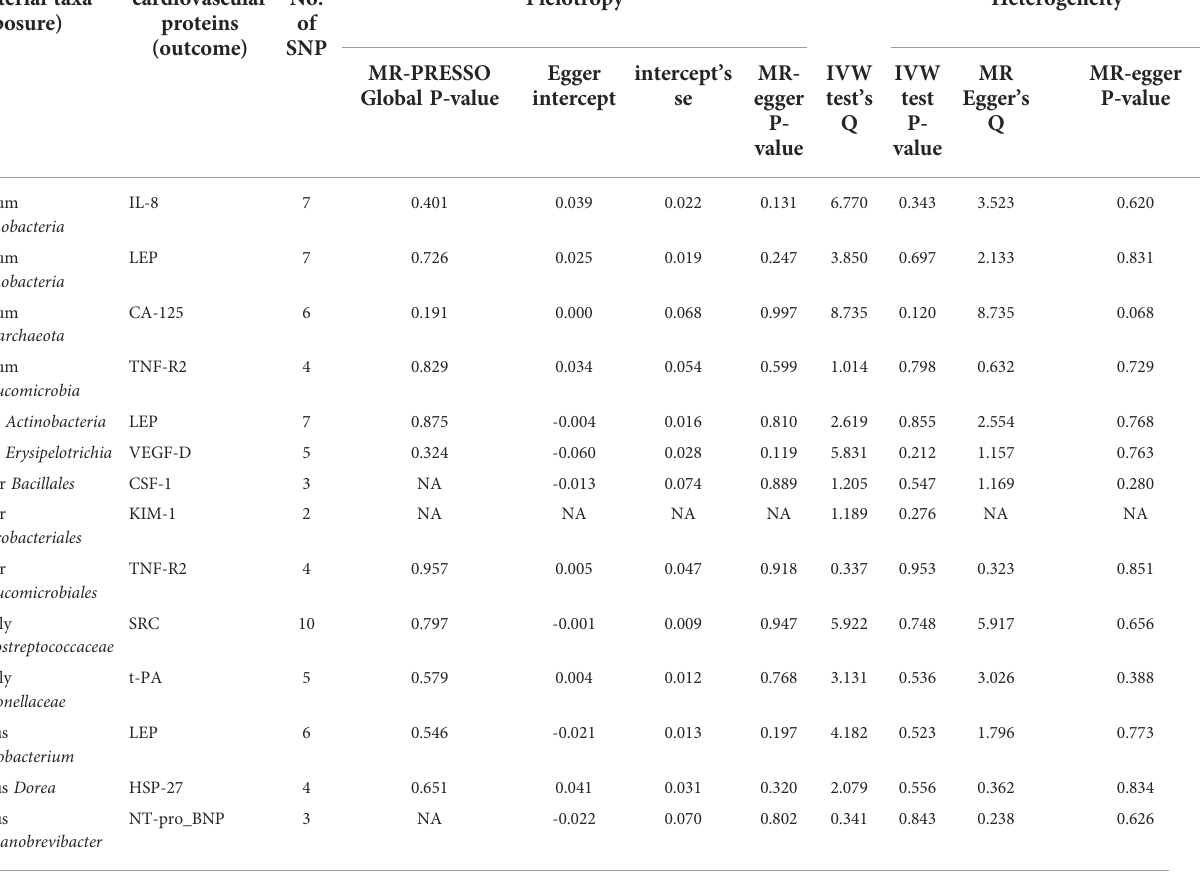
IL-8, Interleukin-8. LEP, Leptin. CA-125, Carbohydrate antigen 125. TNF-R2, Tumor necrosis factor receptor 2. VEGF-D, Vascular endothelial growth factor D. CSF-1, Macrophage-colony stimulating factor. KIM-1, Kidney injury molecular1. SRC, Proto-oncogene tyrosine-protein kinase Src. t-PA, Tissue plasminogen activator. HSP-27, Heat shock protein 27. NT-pro_BNP, N-terminal pro-brain natriuretic peptide. NA, Not Applicable. No. of SNP, Number of